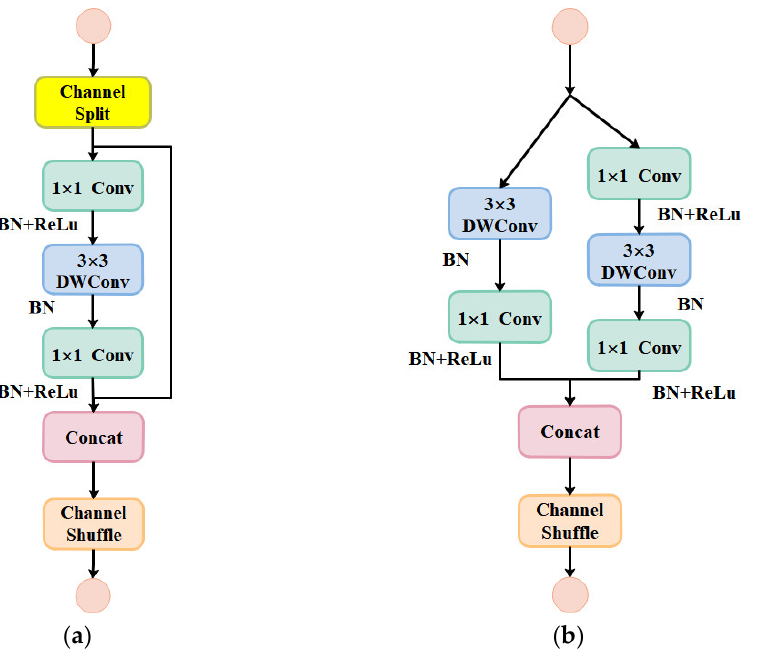
Figure 6. The structure of ShuffleNet-v2 Units. ( a ) the structure of ShuffleNet-v2 Unit1. ( b ) the structure of ShuffleNet-v2 Unit2.